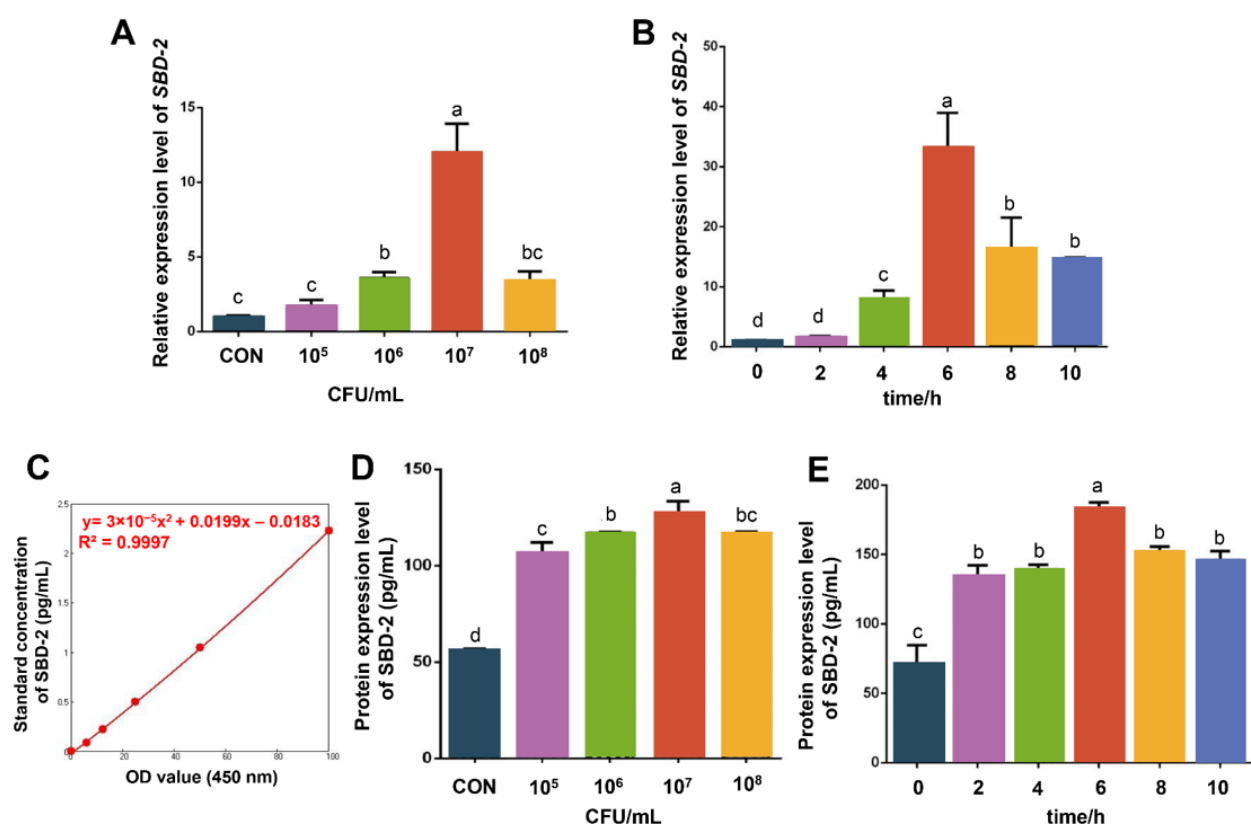
Figure 1. E. coli F17 stimulates mRNA and protein expression levels of SBD-2. ( A ) SBD-2 mRNA expression levels detected by RT-PCR in OIECs treated with the indicated concentrations of E. coli F17 compared with non-treated controls. ( B ) SBD-2 mRNA expression levels detected by RT-PCR in OIECs treated with E. coli F17 (10 7 CFU/mL) for various time intervals compared with non-treated controls. ( C ) Standard curve drawn by SBD-2 protein concentration value ( y axis) and OD value at 450 nm ( x axis). ( D ) SBD-2 protein expression levels detected by ELISA in OIECs treated with the indicated concentrations of E. coli F17 compared with non-treated controls. ( E ) SBD-2 protein expression levels detected by ELISA in OIECs treated with E. coli F17 (10 7 CFU/mL) for various time intervals compared with non-treated controls. Mean values with different letters in the same row are significantly different ( p < 0.05) according to Duncan’s multiple range test; data were shown as mean ± SD, n = 3 biological replicates.